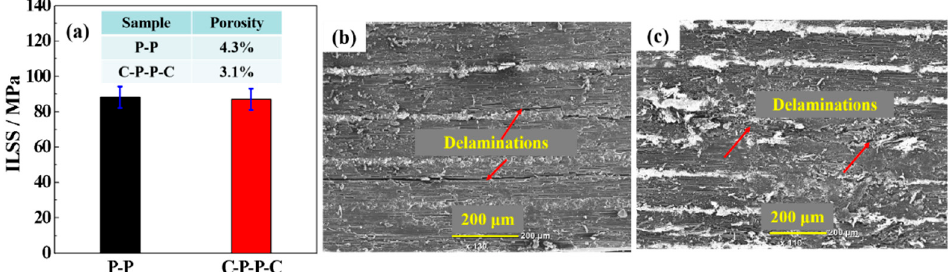
Figure 6. ( a ) ILSS of P-P and C-P-P-C; SEM images of fracture surfaces of ( b ) P-P and ( c ) C-P-P-C.